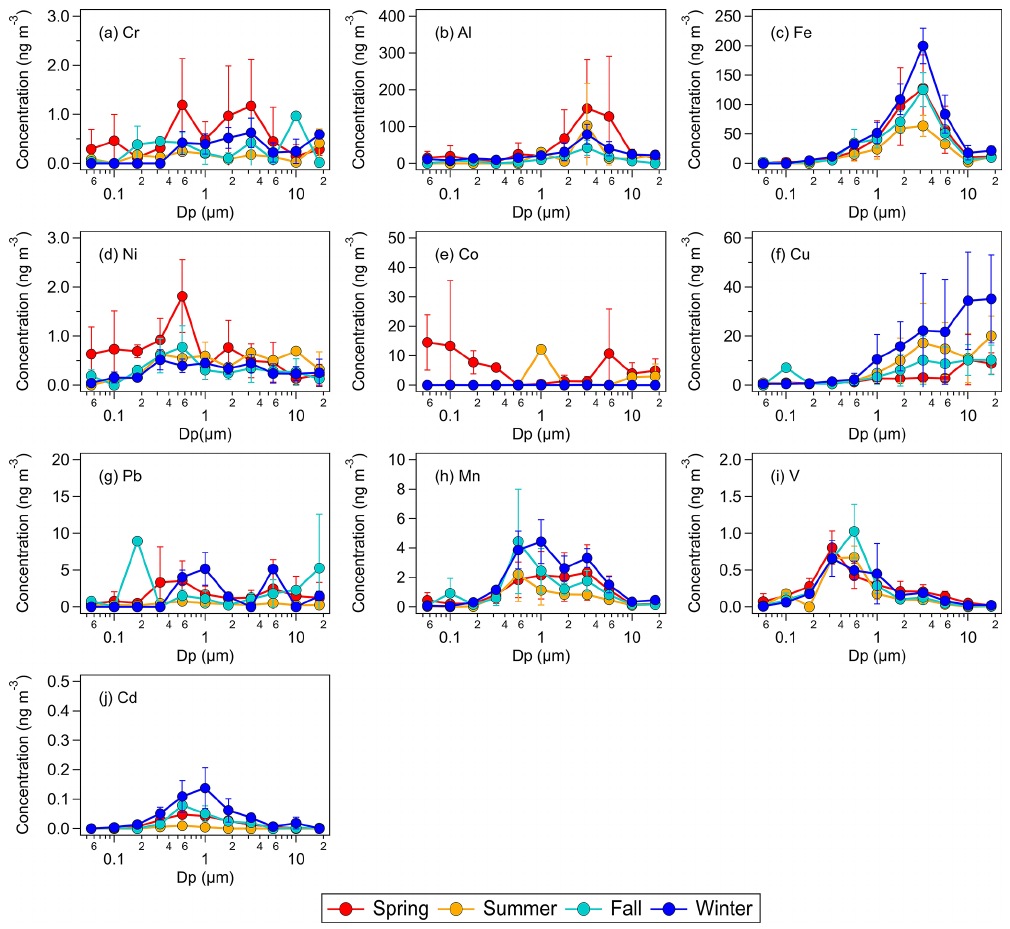
Figure 1. Seasonal average concentrations of total elemental metals in size-fractionated aerosols sampled by the MOUDI with the following nominal cut points (Dp): 0.056µm (size fraction 1), 0.1µm (size fraction 2), 0.18µm (size fraction 3), 0.32µm (size fraction 4), 0.56µm